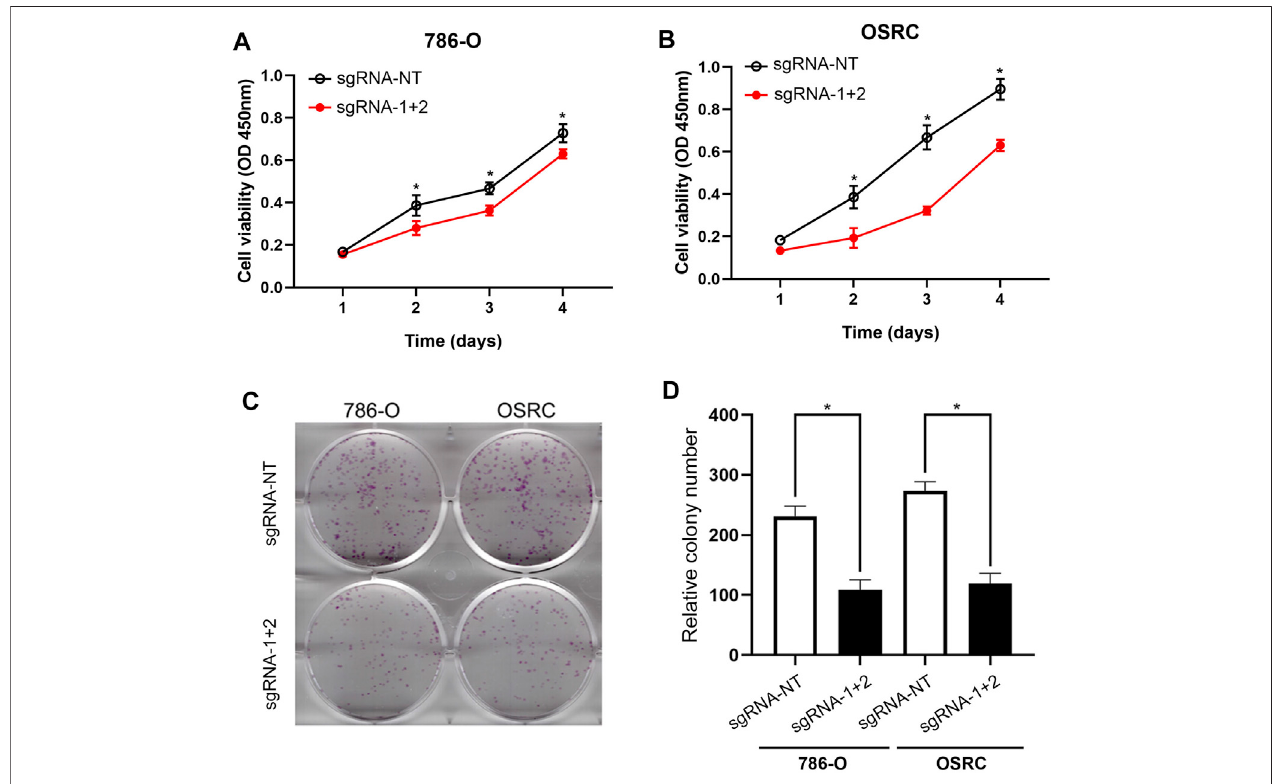
FIGURE 3 | Hypermethylation of LncRNA NEAT1 repressed the RCC cells proliferation. (A,B) CCK-8 assays of 786-O and OSRC cells after transfected with dCas13b-METTL3 and sgRNAs. (C,D) Colony formation assay for 786-O and OSRC cells after transfected with dCas13b-METTL3 and sgRNAs. * p < 0.05.